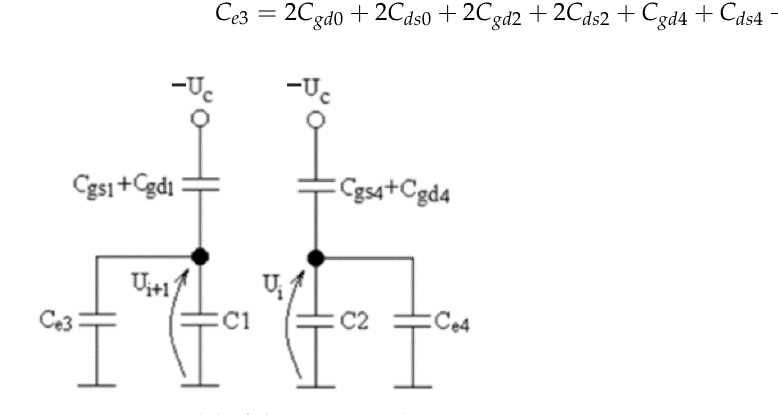
Figure 4. A model of the LADC with successive approximation on SC which takes into account control voltage transmission.